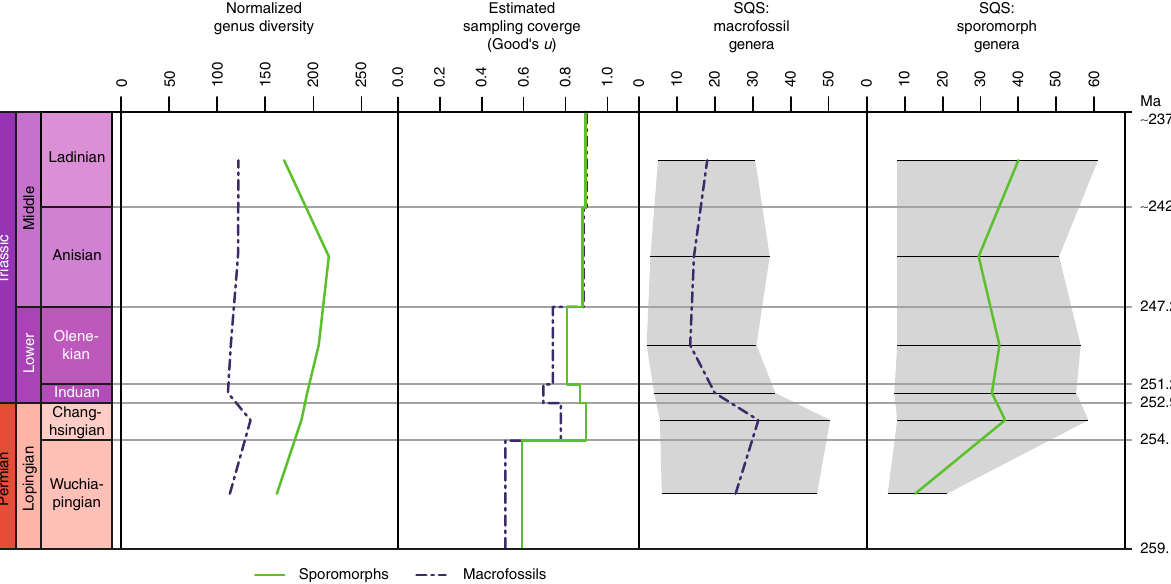
Fig. 3 Normalized genus diversity, sampling coverage and shareholder quorum subsampling. Shareholder quorum subsampling (SQS) uses ‘ sqsbyref ’ function (with: quorum = 0.4, trials = 500, sample.quota = 5, merge.repeats = TRUE; see methods), showing median line and 95% con fi